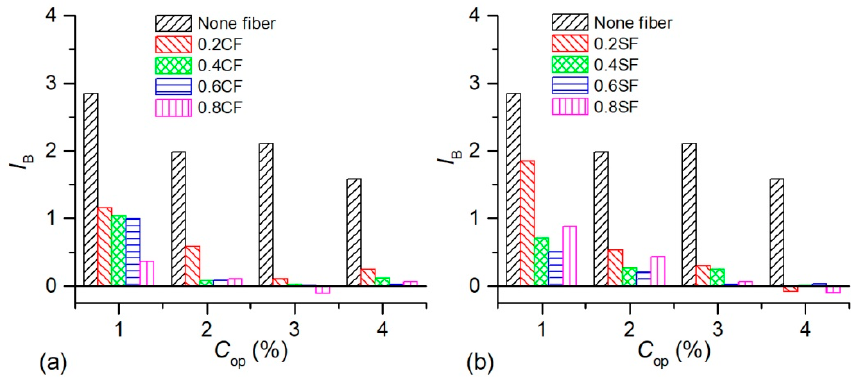
Figure 11. The variation of I B of treated sand with the addition amount of polymer and fibers: ( a ) OPSS and PCFRS. ( b ) OPSS and OPSFRS.